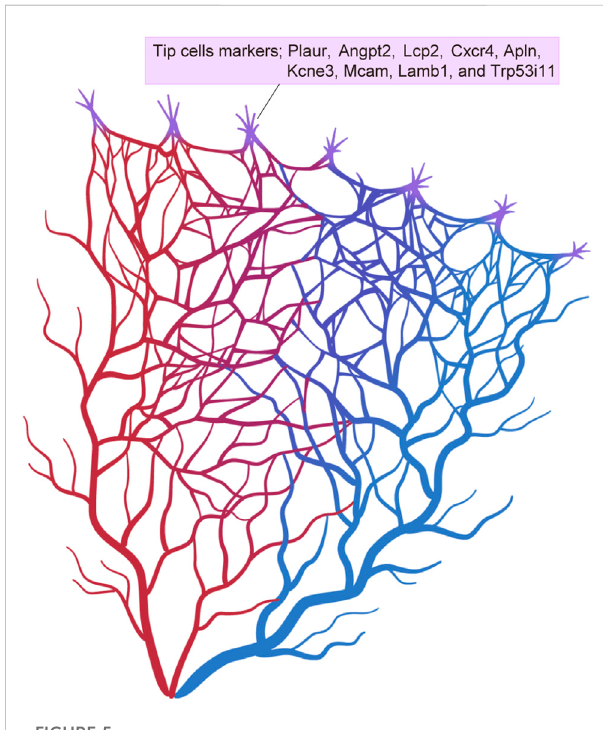
FIGURE 5 Tip cell markers. Single-cell RNA sequencing has identi fi ed various different tip cell markers in the brain and